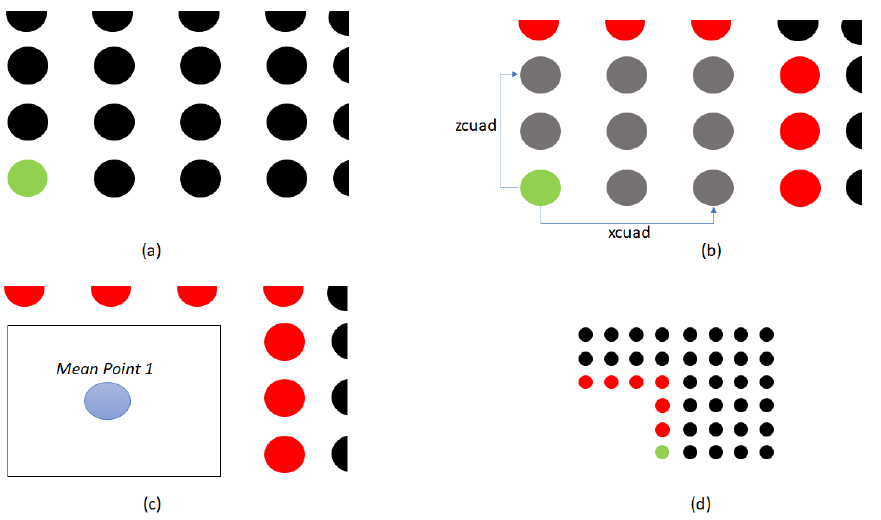
Figure 7. Example of operation of the Voxel filter in 2D: ( a ) Anchor point, ( b ) Anchor point neighbours, ( c ) neighbours approximated to mean coordinates, ( d ) new anchor point for next